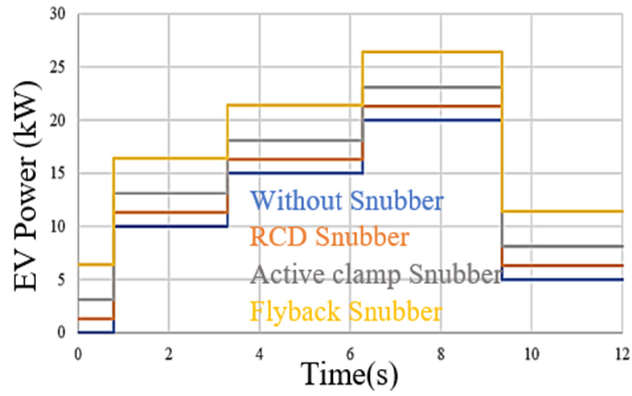
Figure 6. Power response curve of EVs.